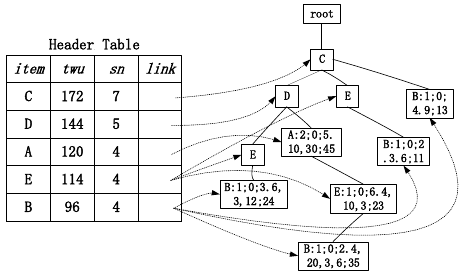
Figure 1. Example tail-node tree (TN-Tree) constructed from the toy data in Tables 1 and